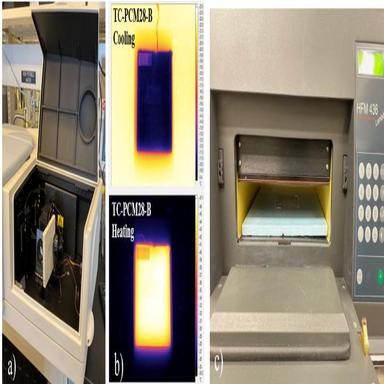
Tools used for the characterization of the samples: (a) Spectrophotometer test; (b) Emissivity test; (c) Thermal conductivity test.